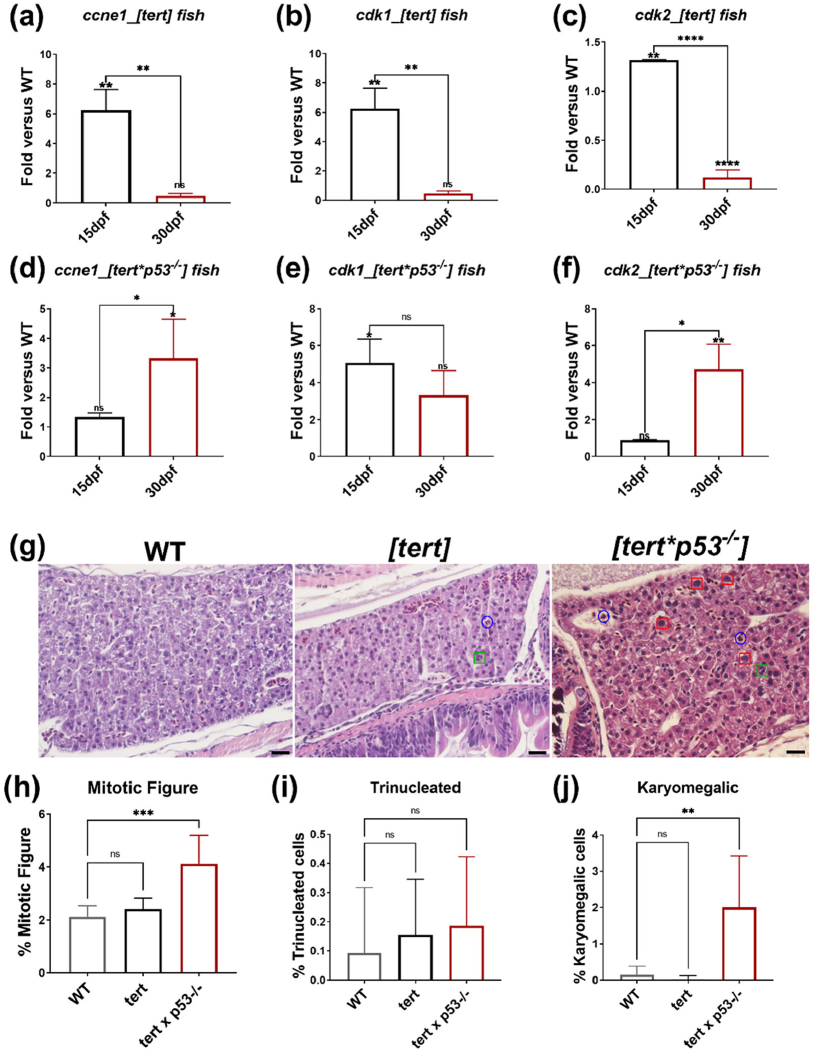
Figure 5. The expression of cell proliferation markers and histopathological features from H&E stain in [tert] and [tert x p53 − / − ] transgenic fish. The expression of proliferation marker in [tert] fish at 15dpf and 30dpf ( a ) ccne1 , ( b ) cdk1 , and ( c ) cdk2 , and in [tert x p53 − / − ] fish at 15dpf and 30dpf ( d ) ccne1 , ( e ) cdk1 , and ( f ) cdk2 . *: p ≦ 0.05; **: p ≦ 0.01; ***: p ≦ 0.001. ( g ) The representative images of H&E stain of WT, [tert] , and [tert x p53 − / − ] fish at 30dpf. The blue circle indicates the mitotic features, the green square points out the trinucleated hepatocytes, the red square denotes the karyomegalic cells. The scale bar is 20 µ m in length. The quantification of histopathological features from H&E stain: ( h ) mitotic figures, ( i ) trinucleated hepatocytes, ( j ) karyomegalic cells are increased in WT, [tert] , and [tert x p53 − / − ] fish at 30dpf. We performed three replicates, and for each qPCR, there were triplicates for each sample. Ten embryos were included in each experiment. One-way ANOVA analysis fol- lowed by multiple analysis was used to identify the statistical significance between groups. *: p ≦ 0.05; **: p ≦ 0.01; ***: p ≦ 0.001; ****: p ≦ 0.0001; ns: no-significance.